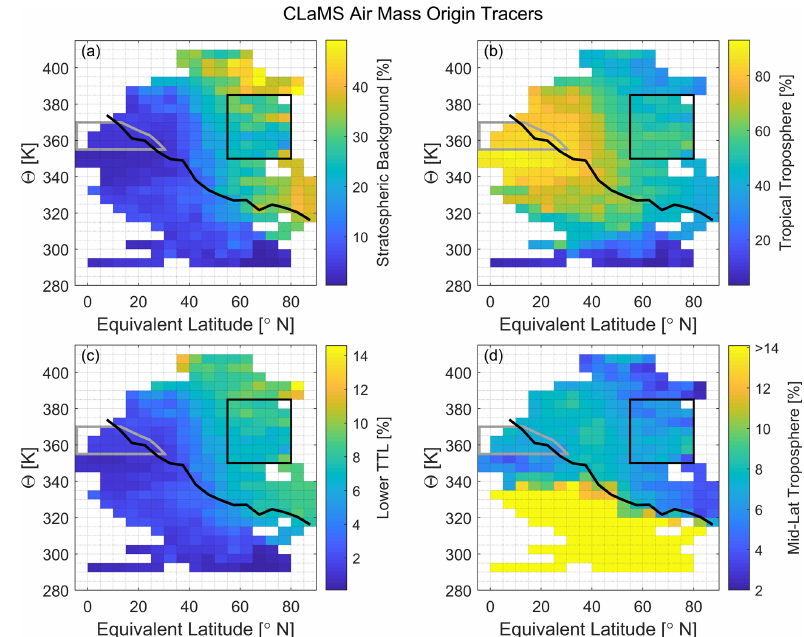
Figure 8. CLaMS air mass origin tracers from WISE flights are initialized 5 months prior to the campaign. The atmospheric model is divided into nine domains. Shown are (a) the stratospheric background, (b) the tropical troposphere, (c) the lower TTL ( (cid:50) = 355–380K), and (d) the midlatitudinal troposphere. The remaining domains include the upper TTL ( (cid:50) = 380–425K), the tropical pipe, the midlatitudinal LMS, the polar troposphere, and the polar LMS (not shown). The solid black line is the campaign-average WMO TP, the black box indicates the area of the HBrR, and the gray outline marks the tropical (cid:50) high –PV low region (discussed in the text).